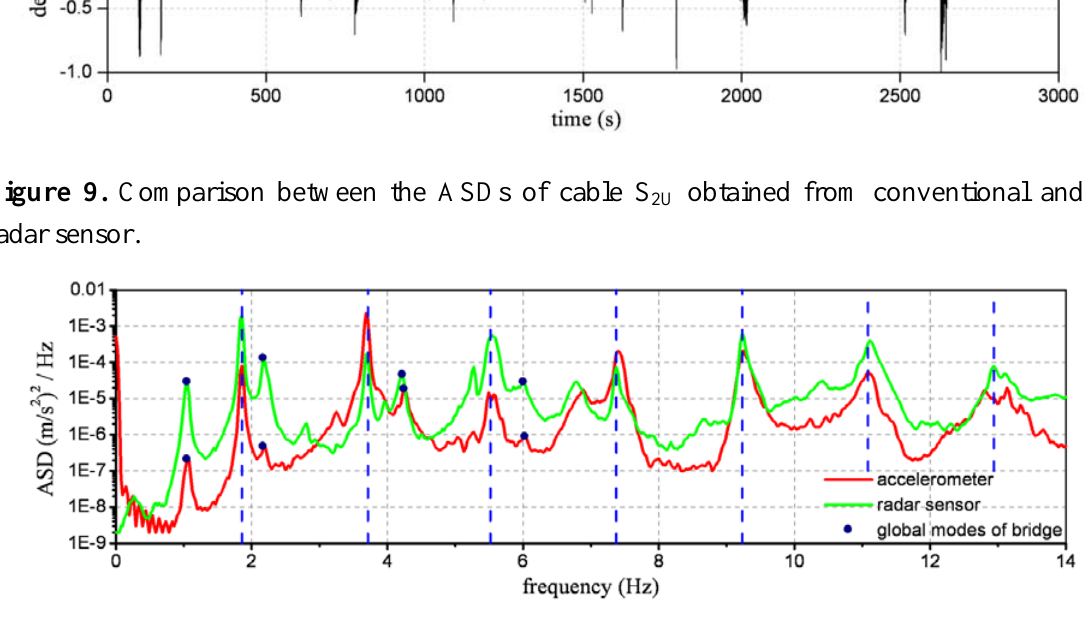
obtained from conventional and 2U